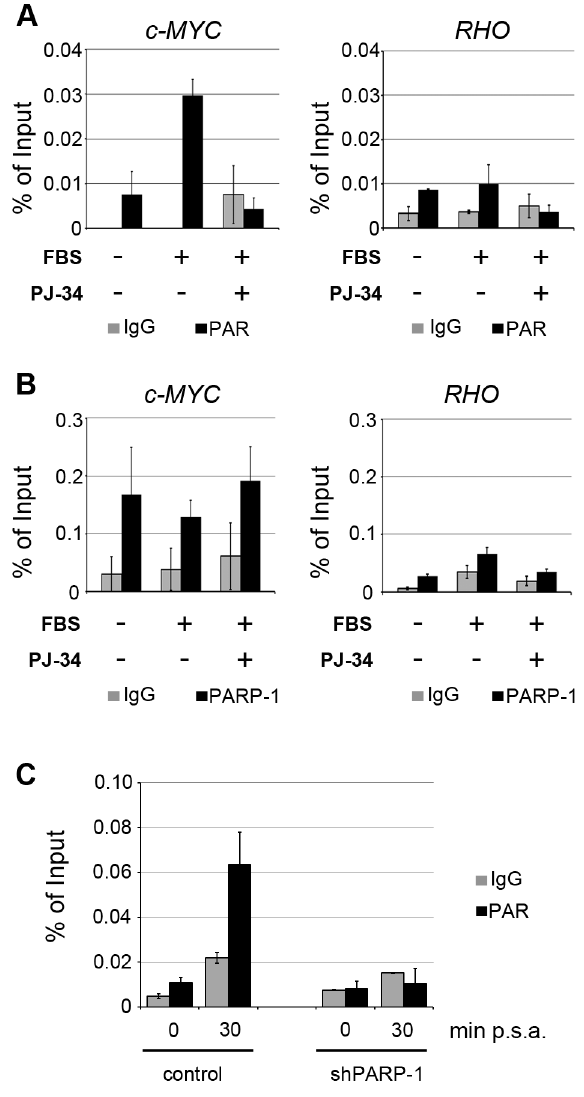
Figure 3. Poly(ADP-ribosyl)ation of c-MYC promoter is medi- ated by PARP-1. A, Chromatin poly(ADP-ribosyl)ation at c-MYC promoter investigated by ChIP assays. Chromatin samples from quiescent cells (-FBS) or from cells stimulated for 30 minutes ( + FBS) in the presence or absence of the PARP inhibitor PJ-34, were immuno- precipitated with an antibody specific for poly(ADP-ribose) (PAR) or a normal mouse IgG. Input and immuno-precipitated samples were subjected to qPCR with primers specific for the fragment including both fr.2 and fr.3 (fr.2 + 3) of c-MYC promoter region (c-MYC). The RHO promoter was used as negative control of the binding. The results were plotted as % of Input and are representative of two independent experiments. The error bars represent the SD of three technical replicates. B, PARP-1 binding to c-MYC promoter assessed by ChIP. Chromatin samples were obtained as described in A and